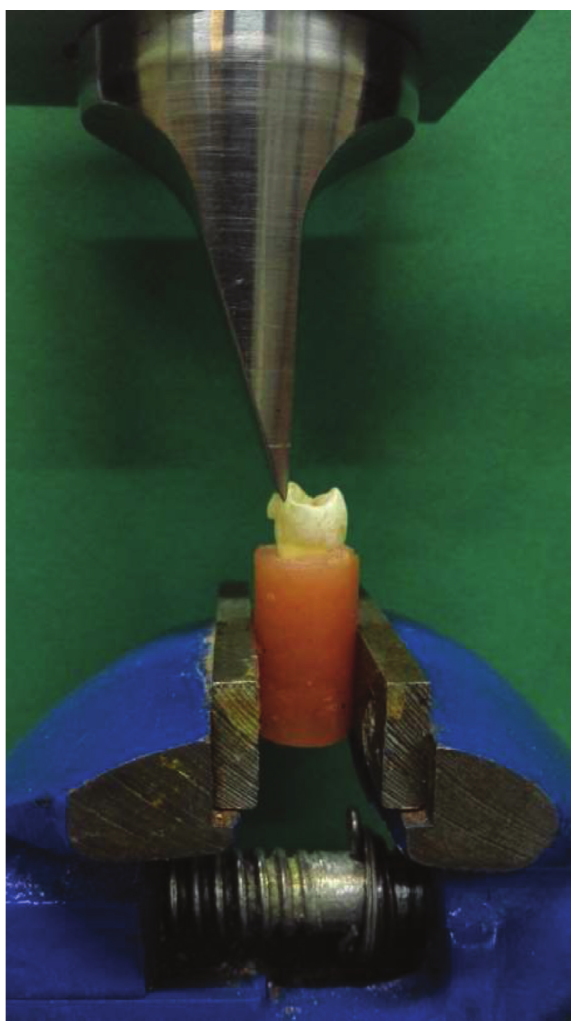
Figure 2: A prepared sample in the universal testing Table 1: The mean shear bond strength ( ± SD) of the study groups.